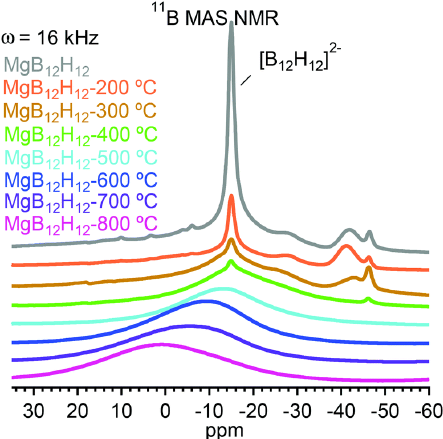
Figure 8. 11 B MAS-NMR spectra of anhydrous MgB 12 H 12 heated to respective temperatures between 190 and 800 ◦ C. Reprinted from [95].